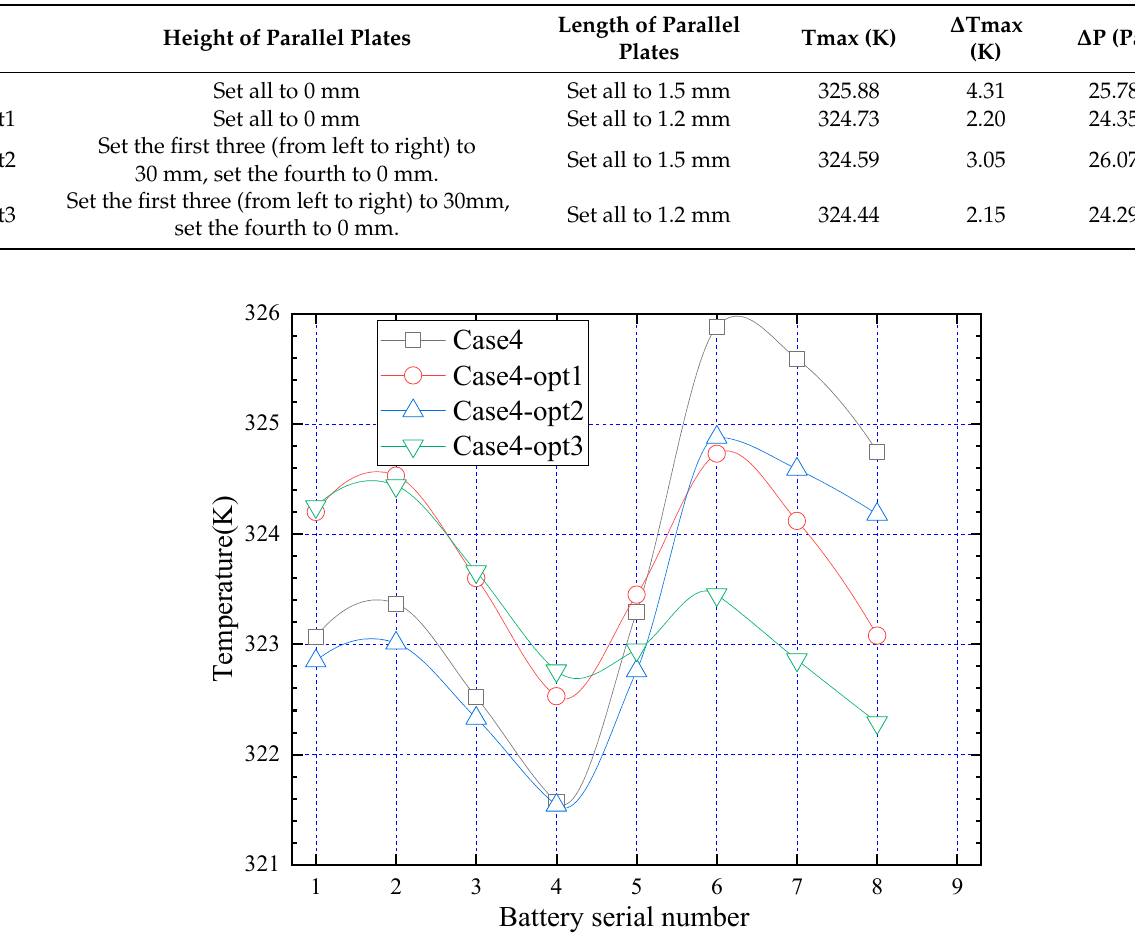
Table 1. Specific measures corresponding to each scheme.